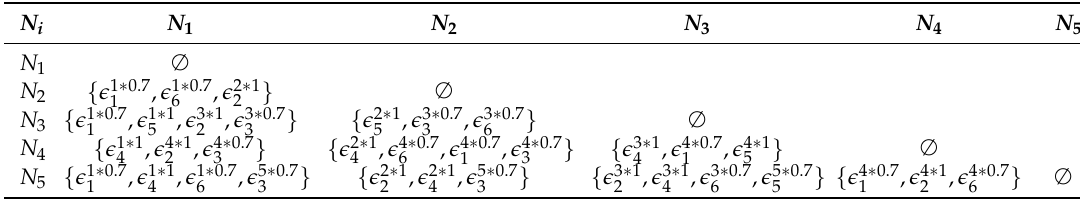
Table 9. The WSDM of Example